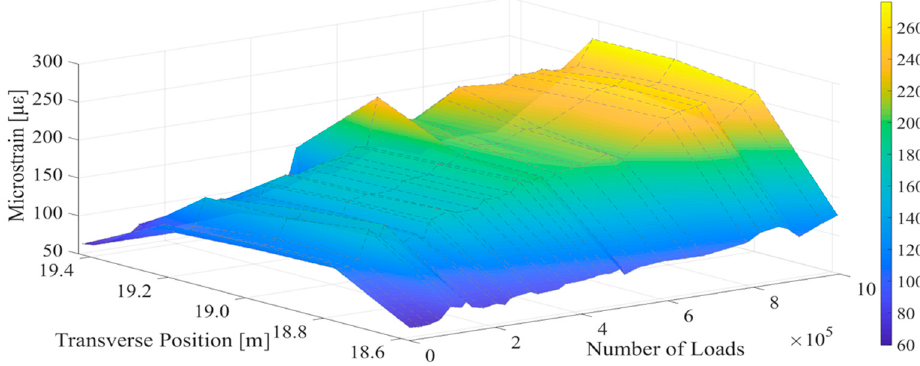
Figure 9. Evolution of deformation versus number of loads and transversal position.